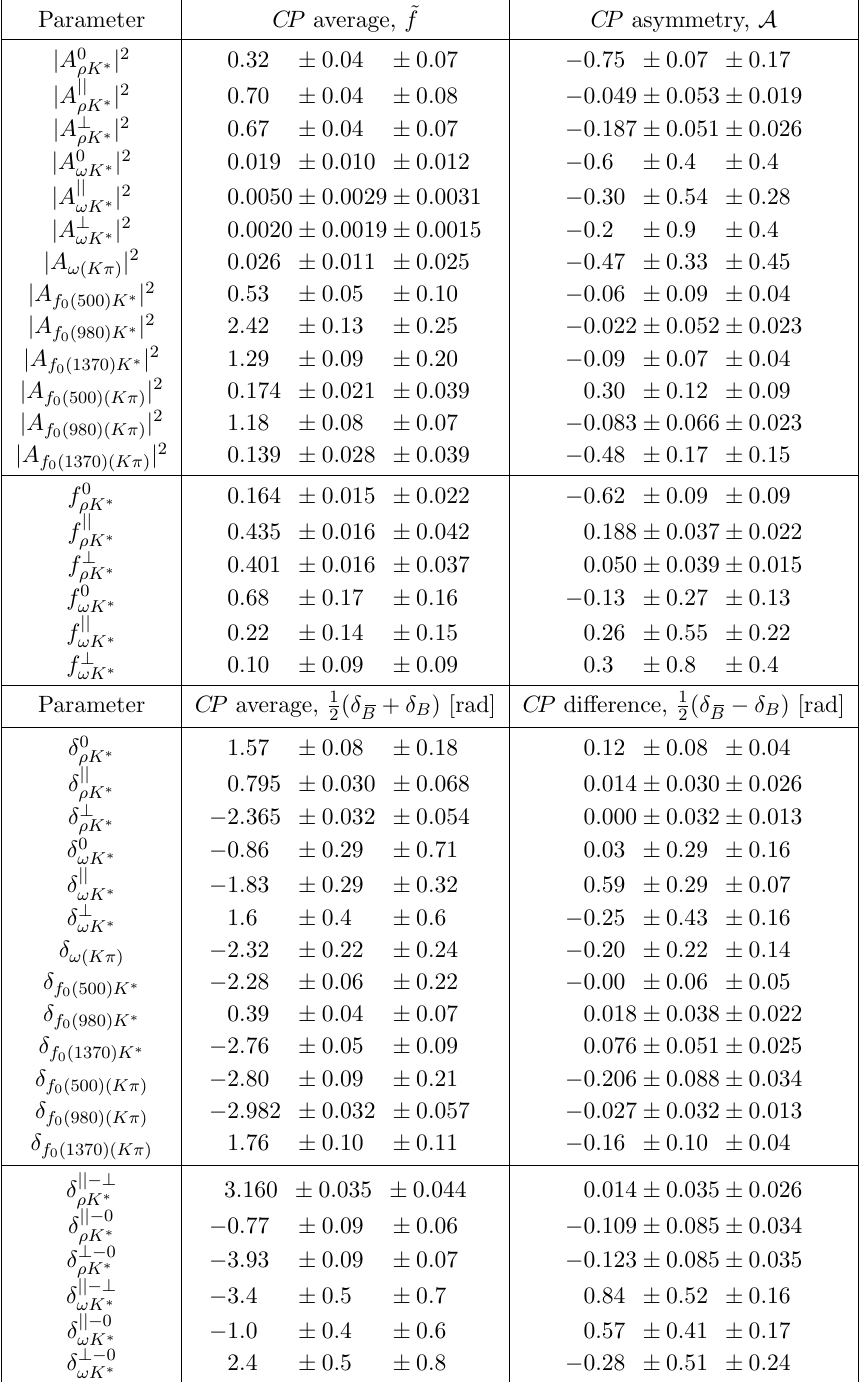
Table 3. Numerical (cid:12)t results for the CP averages and asymmetries in the (top) modulus and (bottom) phase di(cid:11)erences of all the contributing amplitudes and among the V V polarisation frac- tions. For the numbers in the table, the (cid:12)rst and second uncertainties correspond to the statistical and total systematic, respectively. The total systematic uncertainty is obtained from the sum in quadrature of the individual sources detailed in section 7, accounting for 100% correlation of the common systematic uncertainties for B 0 and B 0 .